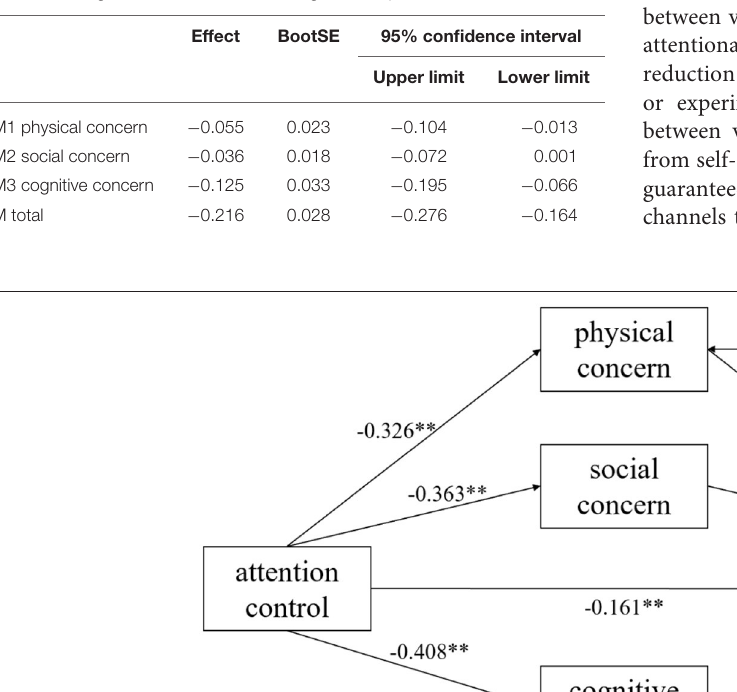
Frontiers in Psychiatry |